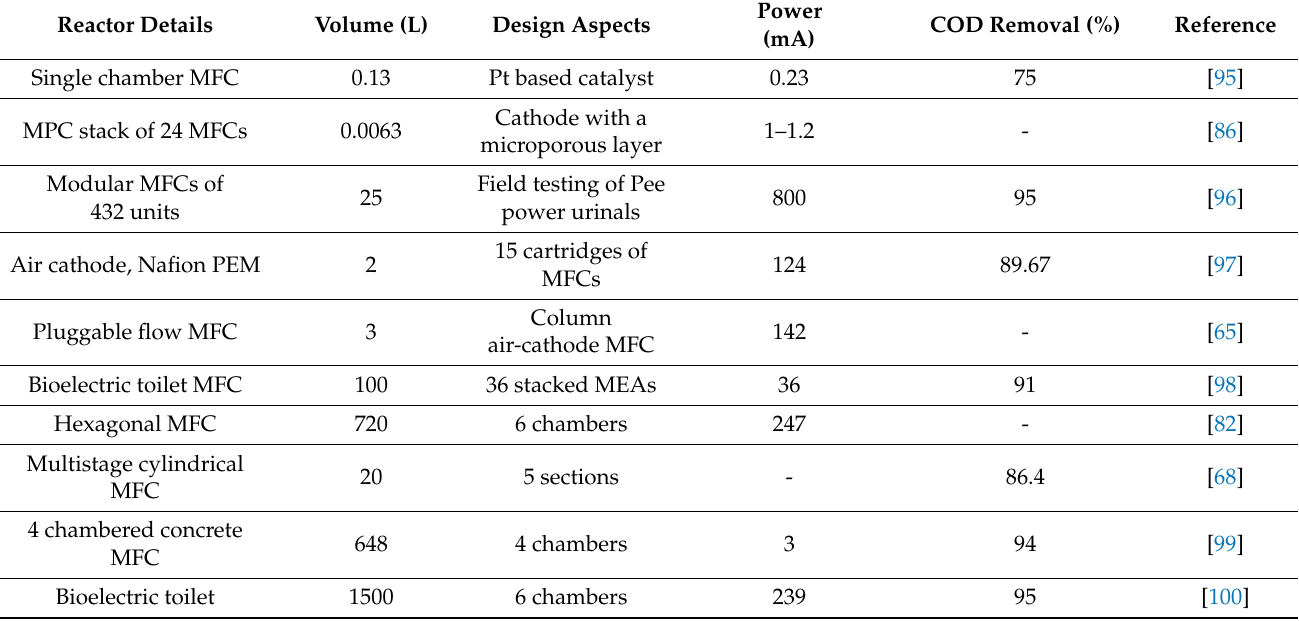
Table 3. MFCs used in scaling-up investigations for treatment of human waste and power